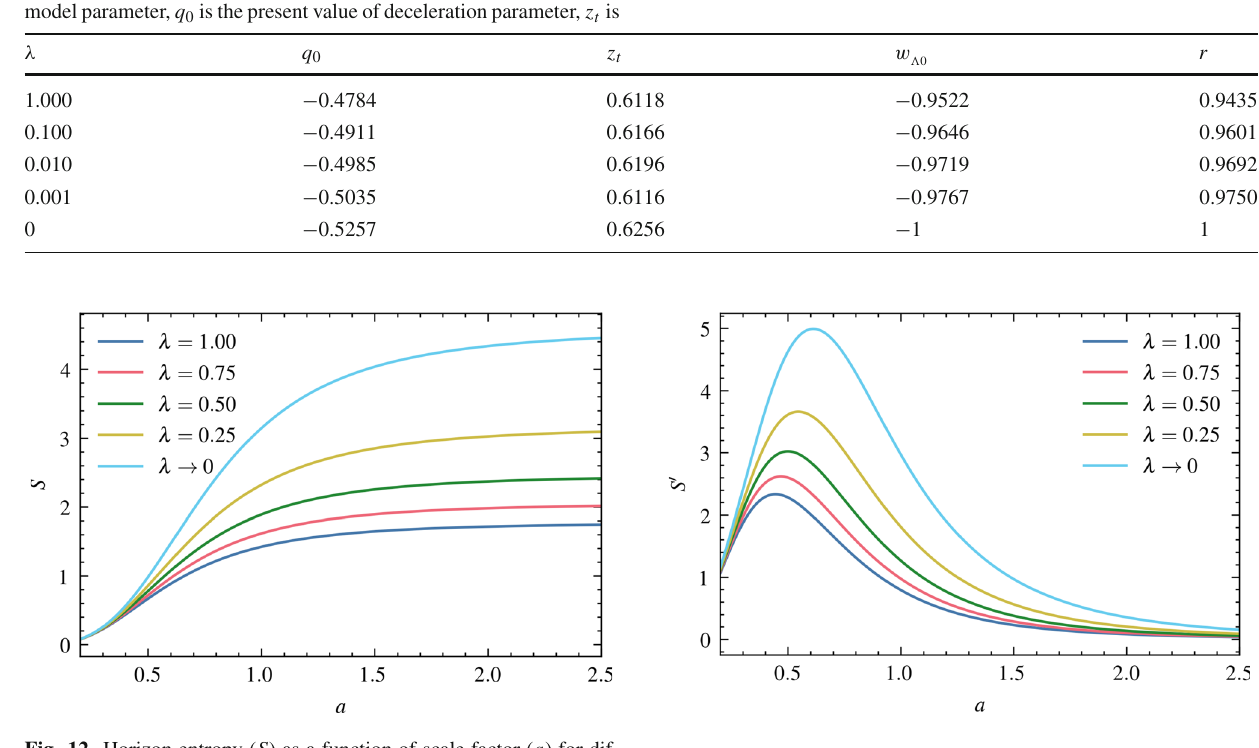
is the present value of dark energy equation the transition redshift, w (cid:2) 0 of state and r is the jerk parameter (also the 1 st statefinder parameter)